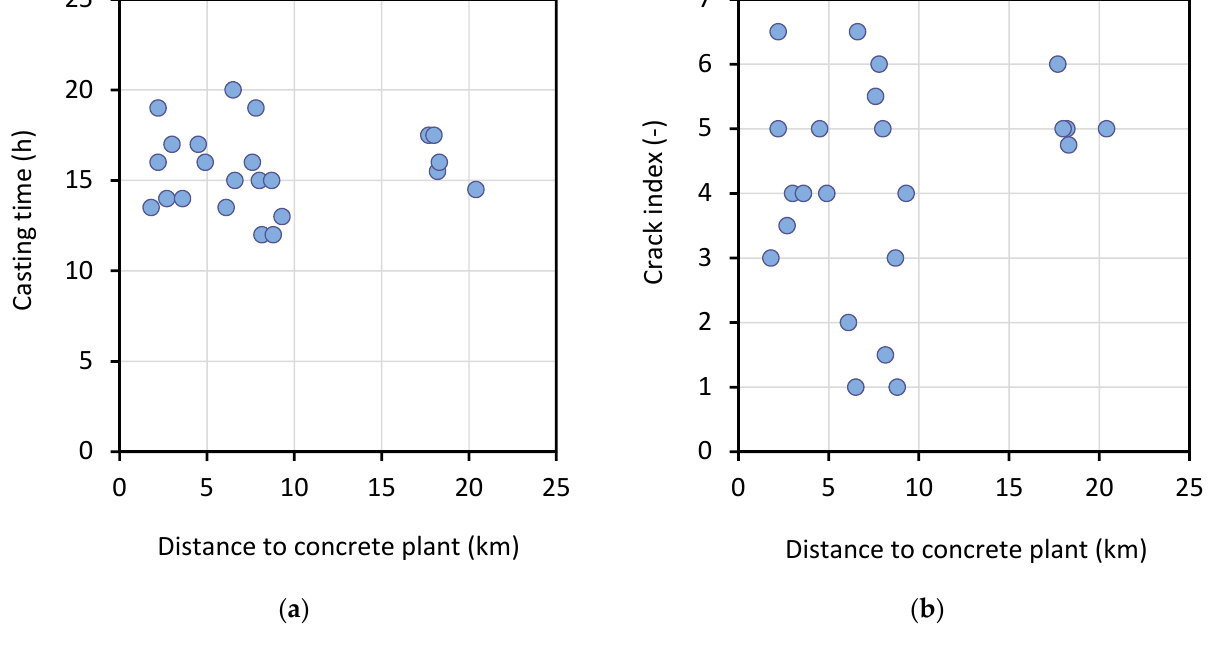
Figure 13. Casting time ( a ) and cracking index ( b ) with respect to the distance between the founda- tions and the temporary concrete batching plant on site. Figure 14. In-situ compressive strength, f is , versus ( a ) density, and ( b ) age of the concrete for test specimens taken from cores drilled on the foundations, for different depths from the top concrete surface.